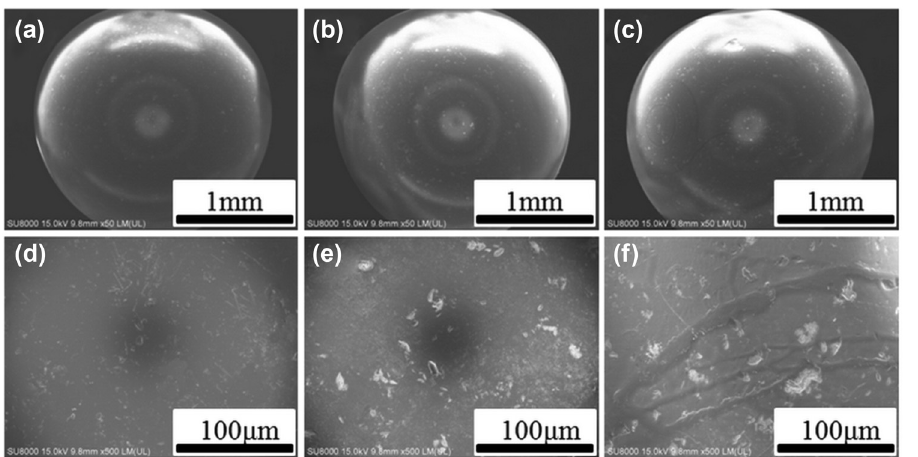
Figure 5: Surface morphology of glass spheres ( a and d ) , immersed composite carriers ( b and e ) , and sprayed composite carriers ( c and f )